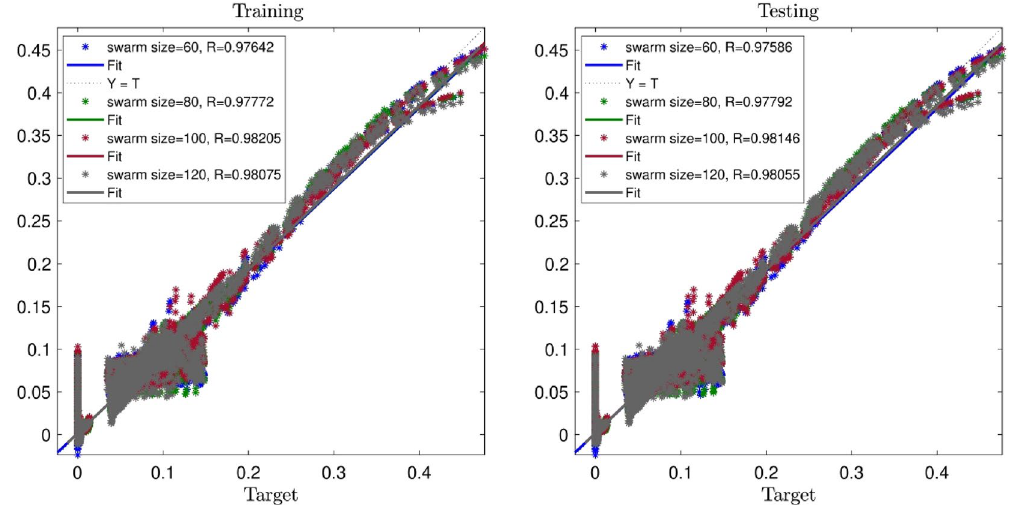
Figure 5. PSOFIS learning processes with considering changes in swarm size when number of inputs is 3.